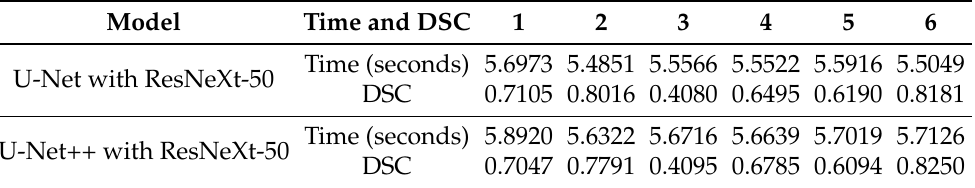
Table 5. Final metrics for U-Net and U-Net++ were obtained for each of the six final testing patients.